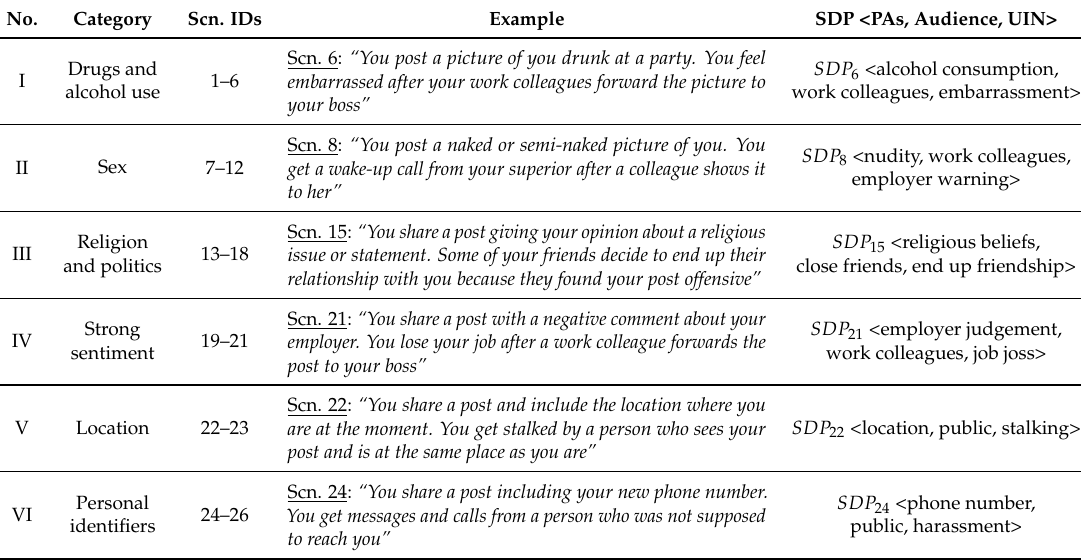
Table 1. Categories of self-disclosure